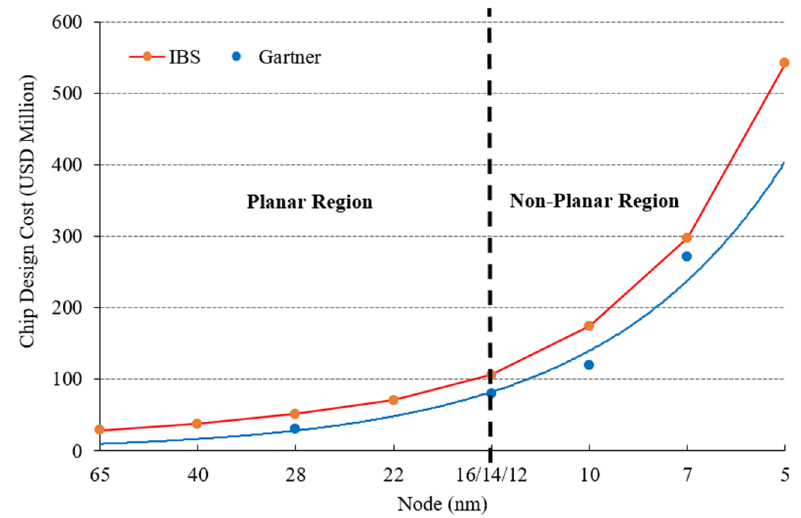
Figure 1. Chip design costs as the technology node advances.